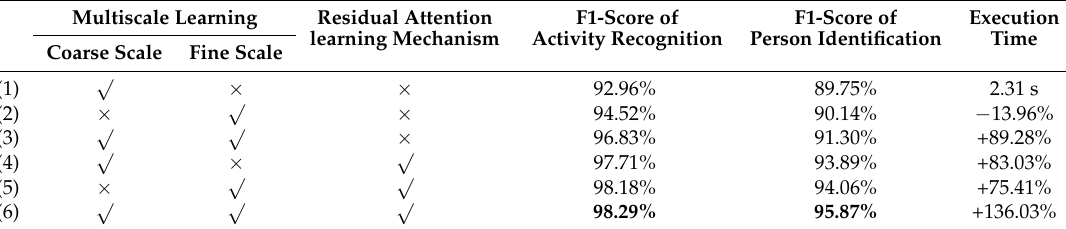
Table 6. Ablation study on MRA-Net